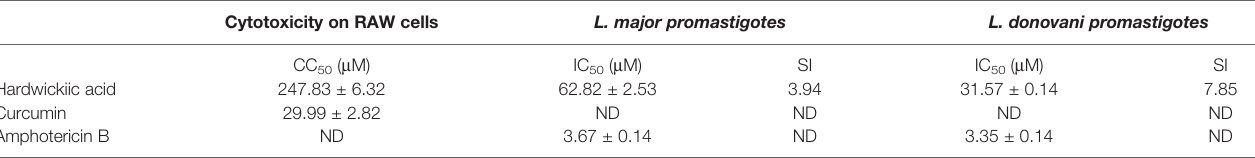
TABLE 1 | Antileishmanial and cytotoxicity activities.